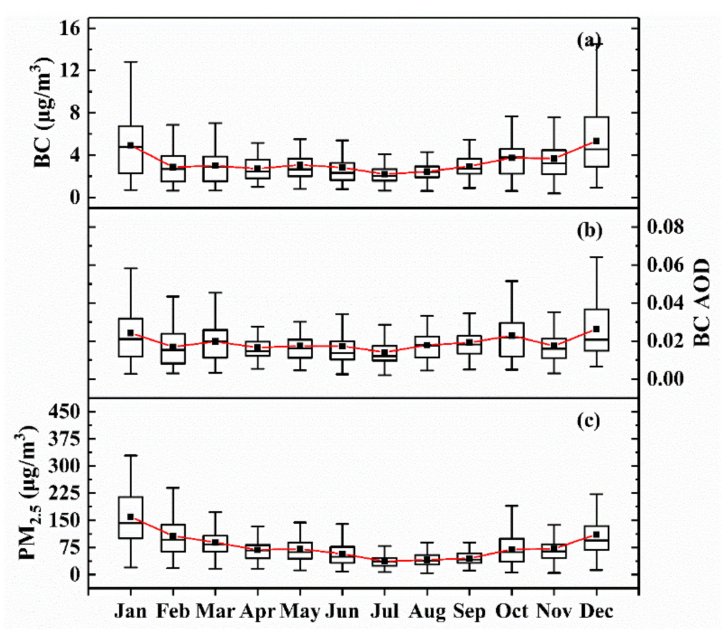
Figure 2. Monthly variation of ( a ) BC mass concentration; ( b ) BC AOD; ( c ) PM 2.5 mass concentration over Wuhan from 2013 to 2016. The red lines are the connection of the monthly averages over the years, and the vertical bars correspond to one standard deviation from the